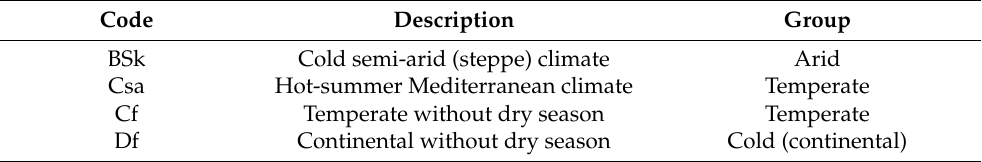
Table A2. Different climate areas of the Köppen climate classification [77–79] considered in this